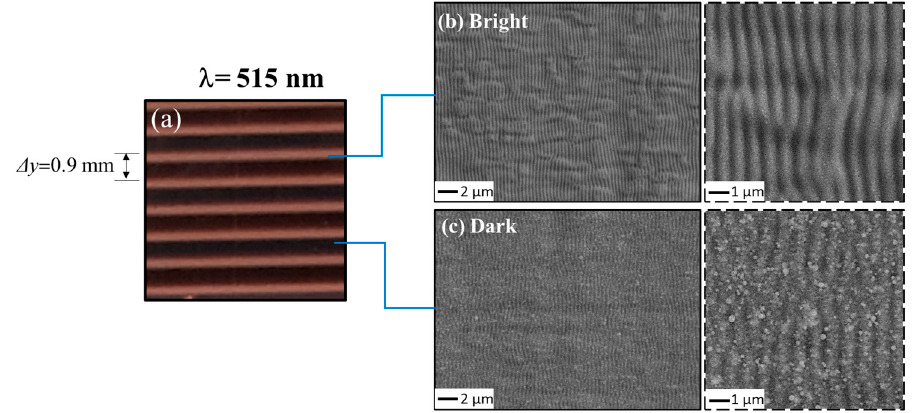
Figure 4. Exemplificative optical and SEM images of the copper sample processed with the cylindrical lens focusing at λ = 515 nm, with a repetition rate f p = 5 kHz and scanning speed u s = 0.5 mm/s, a pulse energy E ≈ 4.5 μ J ( F p ≈ 0.4 J/cm 2 ) and hatch distance Δ y = 0.9 mm. Panel ( a ) displays a photograph of the sample surface evidencing the formation of bright and dark stripes. Panels ( b , c ) report SEM images of the corresponding bright and dark bands, respectively. The insets of the SEM images show zoomed views in the two bright and dark regions, illustrating the finer morphology of the ripples.